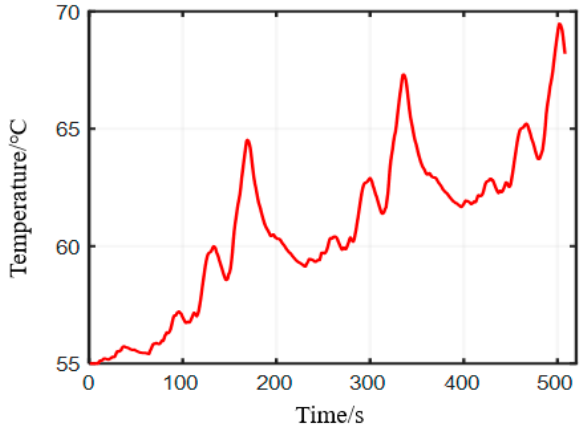
Figure 9. Rotor temperature distribution diagram.